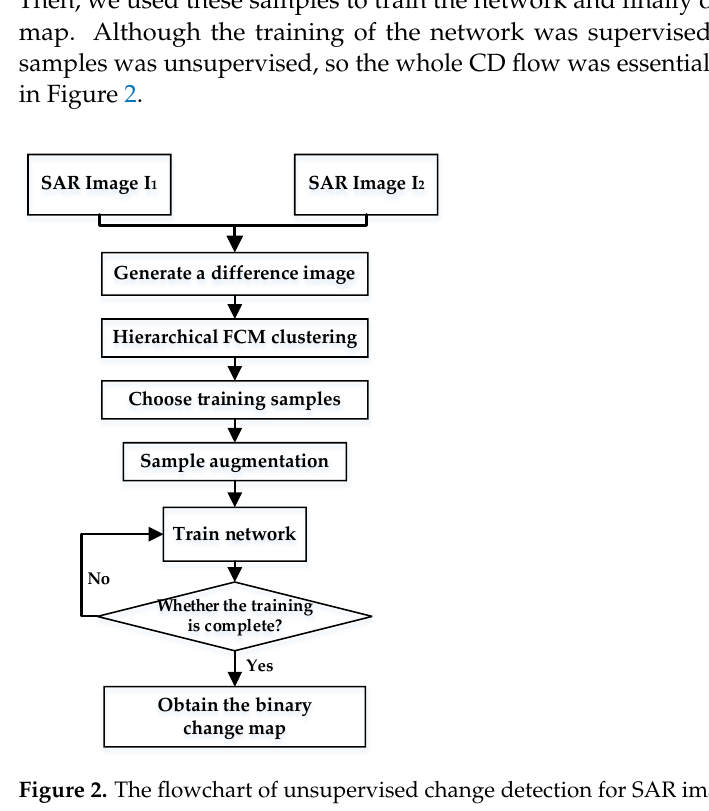
Figure 2. The flowchart of unsupervised change detection for SAR image.